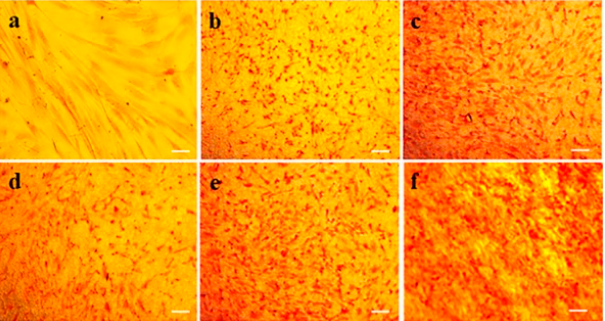
Figure 7. Extracellular matrix (ECM) deposition of fibroblasts by Sirius red staining for collagen expression on Day 6 ( a ) TCP, ( b ) PCL, ( c ) PCL / AV, ( d ) PCL / CUR, ( e ) PCL / AV / CUR, ( f ) PCL / AV / TCH. Scale Bar = 50 µ